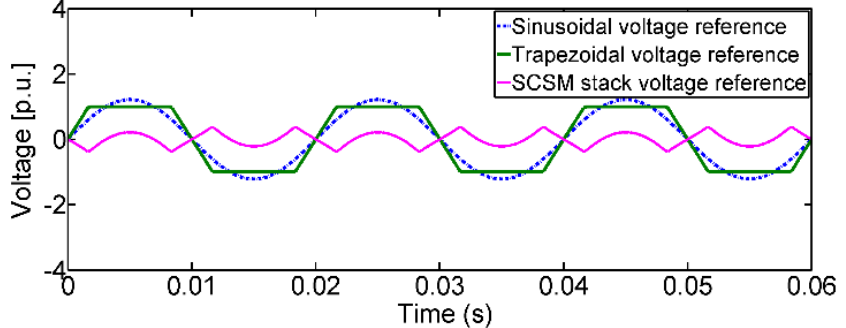
Figure 13. Modulation waveforms of the proposed hybrid MMC.